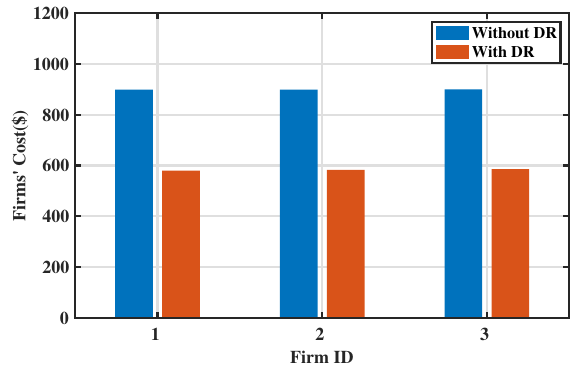
Figure 9. Firms’ daily costs with and without